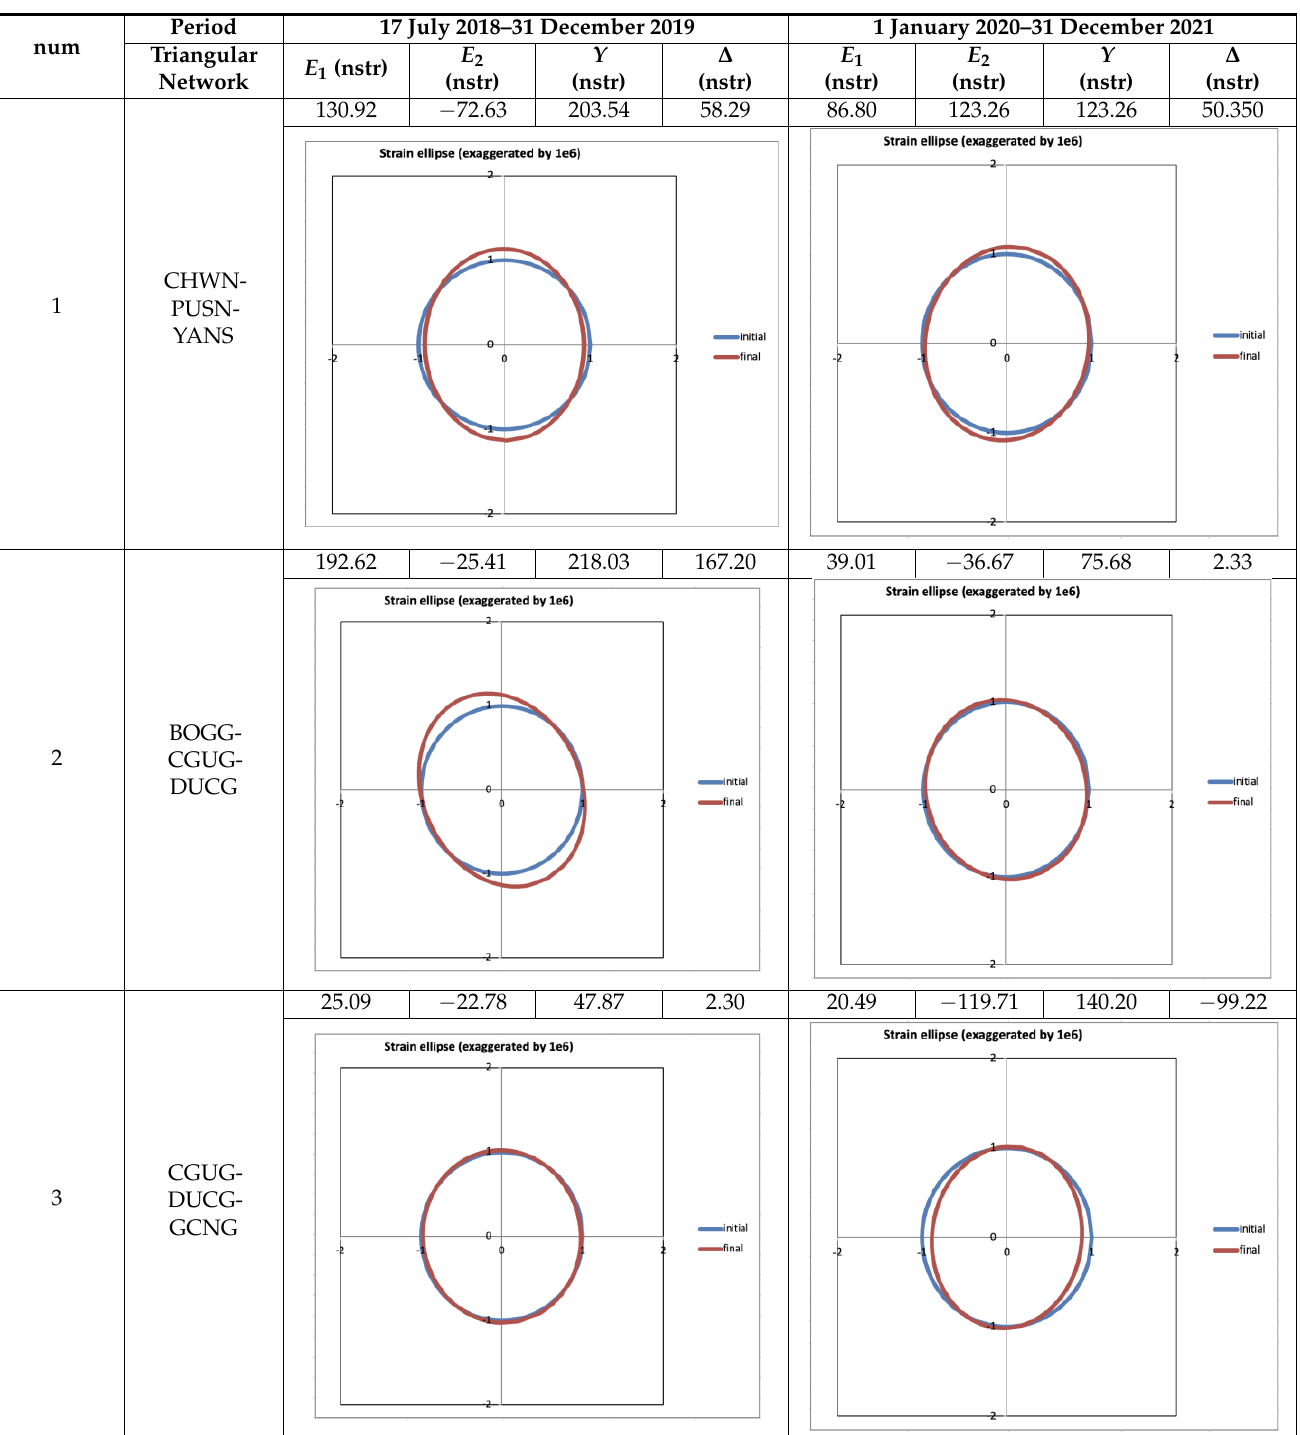
Table 5. Stress strain by triangular network.